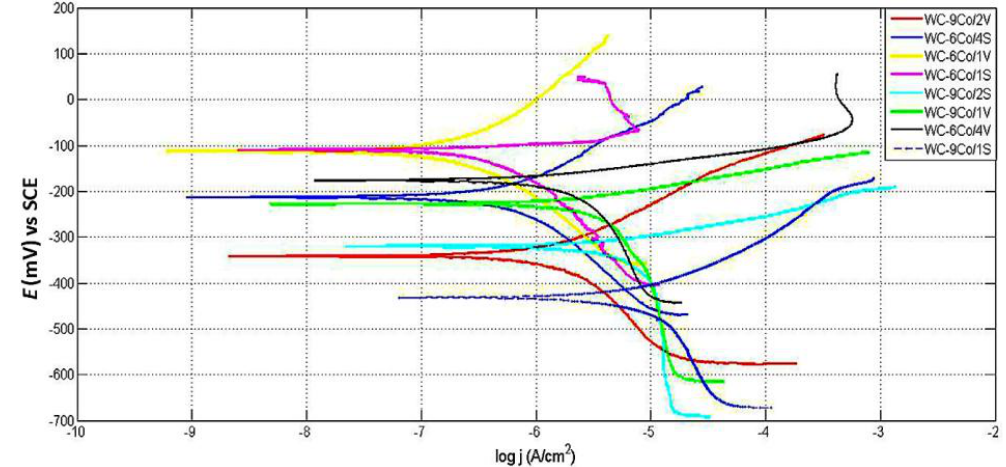
Figure 2. Potentiodynamic polarisation curves (Tafel extrapolation diagram) of samples.